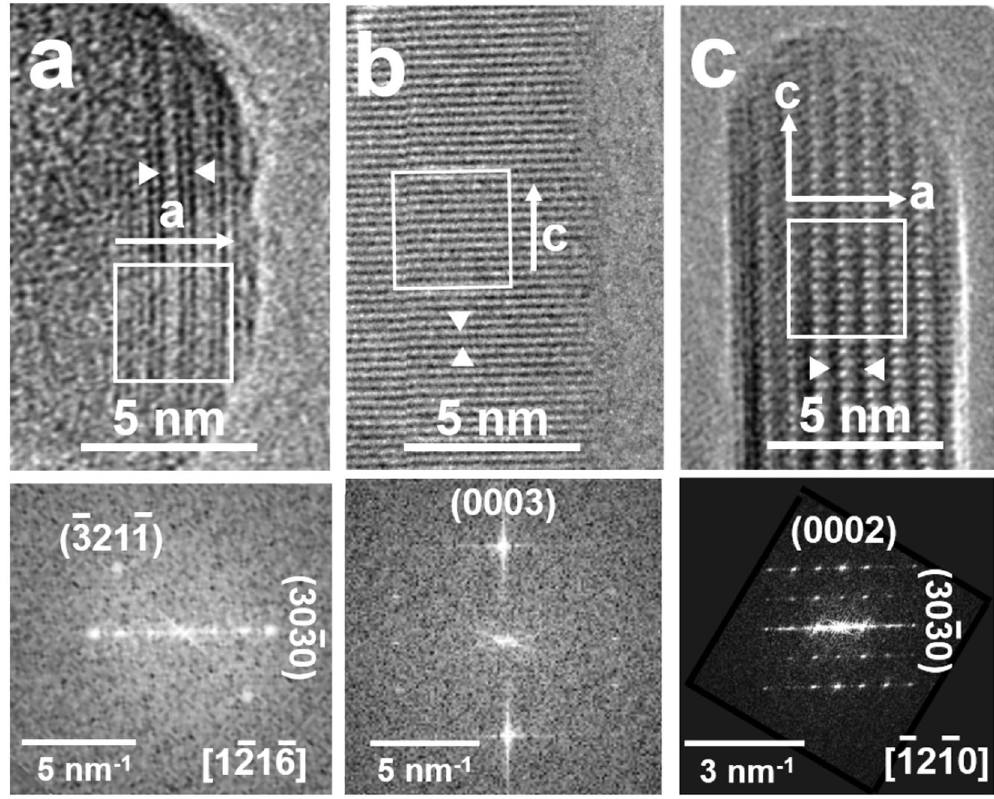
= 0.8154 nm, and {1010}